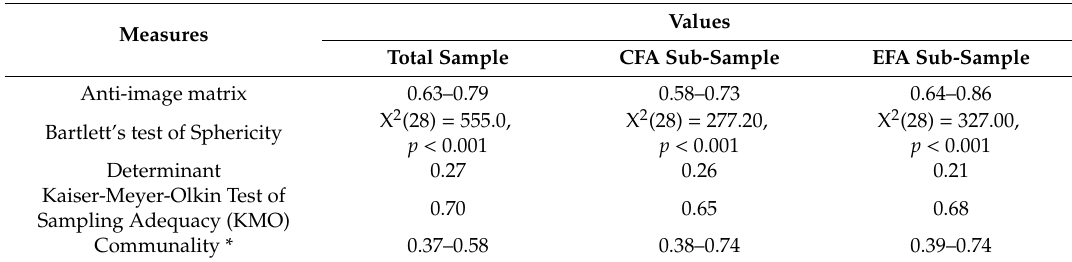
Table 2. Sample size adequacy measures of the Athens Insomnia Scale (AIS) scores in Indian computer professionals.